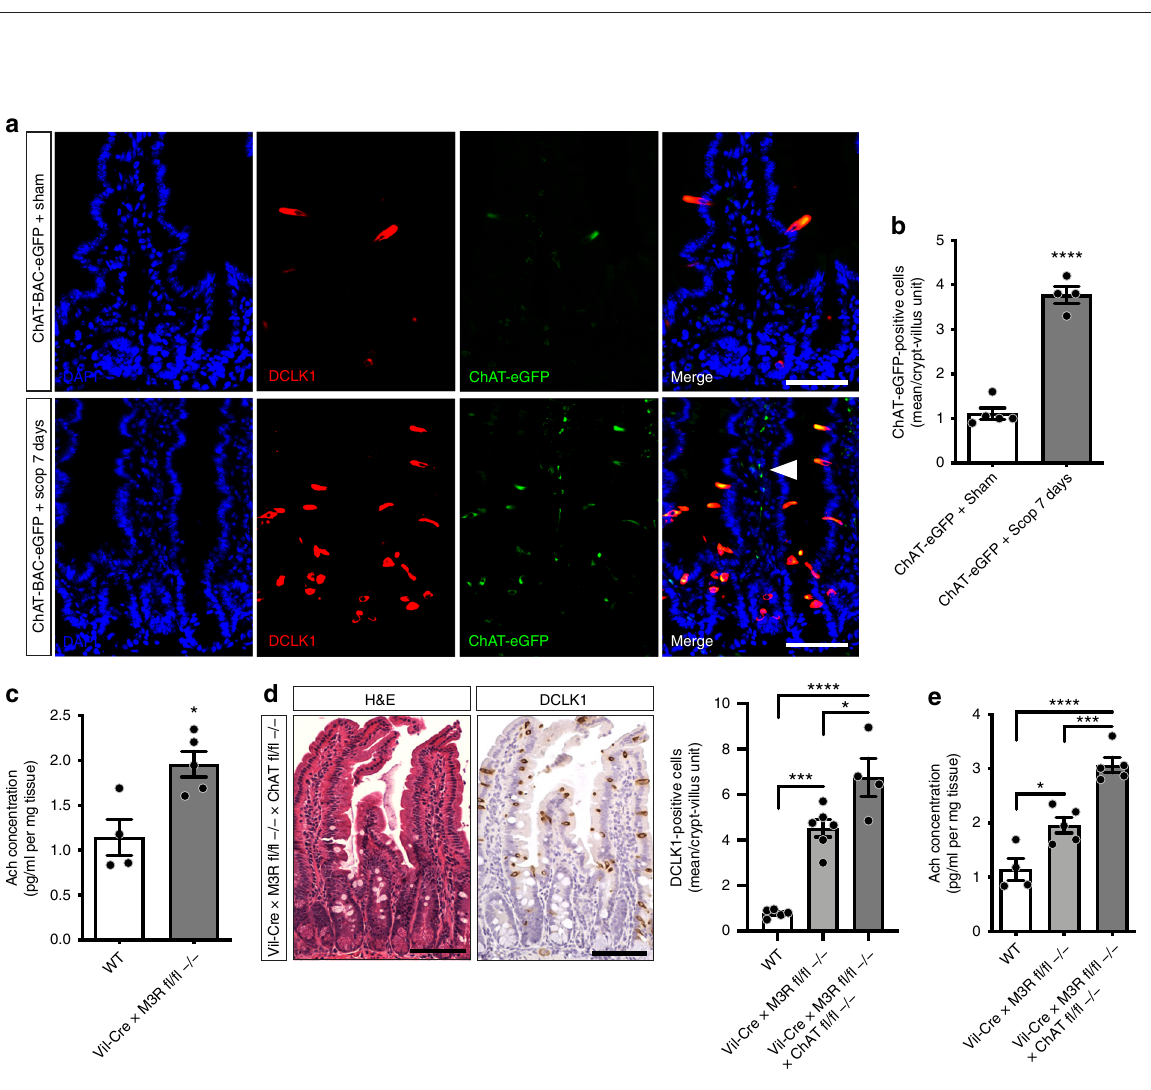
Fig. 3 RNA-sequencing analysis indicates adoption of enteroendocrine differentiation of expanding tuft cells following scopolamine treatment. a Scopolamine-treated Dclk1-DTR-ZSgreen-positive samples ( n = 4 mice) show spatial separation from sham treated samples ( n = 4 samples) along PC1 employing principal component analysis (PCA). b Top 25 differentially expressed genes (DEG) between the indicated groups, scale bar indicates log2-fold changes of genes ( Z -Scores; positive lgFC indicates higher gene expression in the respective group). c Gene set enrichment analysis (GSEA) indicates negative correlation to previously described tuft-1 (neuronal) and tuft-2 (immune) phenotypes following scopolamine treatment; ES enrichment score. d Instead, tuft cells strongly enrich for enteroendocrine cell lineage signatures. e GSEA analysis of published enteroendocrine signature gene sets shows the adoption of an enteroendocrine progenitor subtype as well as increased differentiation into early and late EC cells, L cells and N cells of expanding tuft cells 13,32 (see Supplementary Data 1 for leading edge gene signatures); the enrichment for enterocyte signatures further con fi rms increased differentiation. EEC enteroendocrine cell, EC enterochromaf fi n cell, NES normalized enrichment score. f Master regulator analysis shows signi fi cant changes in transcription factor activity after scopolamine treatment, such as activation of Srebf2 and inactivation of Nme2 , respectively ( Z -Scores; Srebf2 p = 0.00086; Hnf4a p = 0.0014; Ewsr1 p = 0.0019; Taf9 p = 0.0019; Nme2 p = 0.0015; Sarnp p = 0.0011; Scand1 p = 0.00012). FDR false discovery rate, Act differential activity (red indicating increased, blue indicating decreased), Exp differential gene expression.